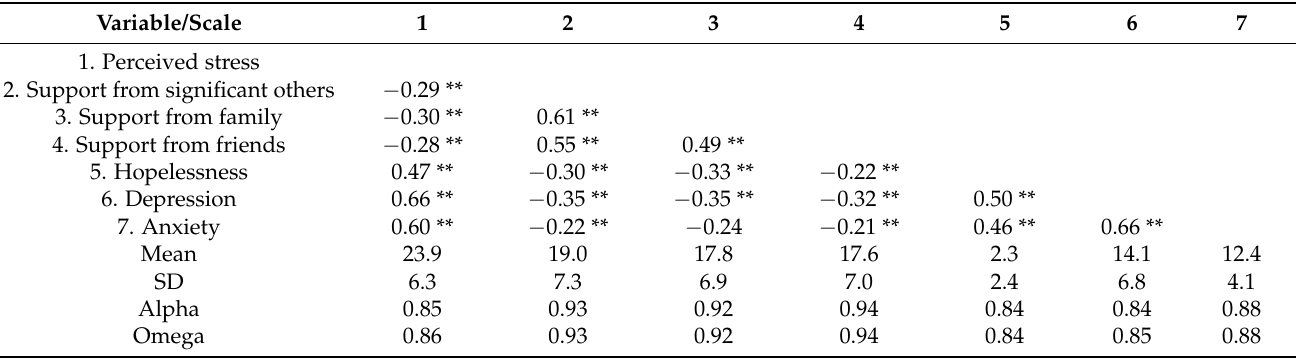
Table 2. The descriptive statistics, as well as the reliability values of and correlations between variables.